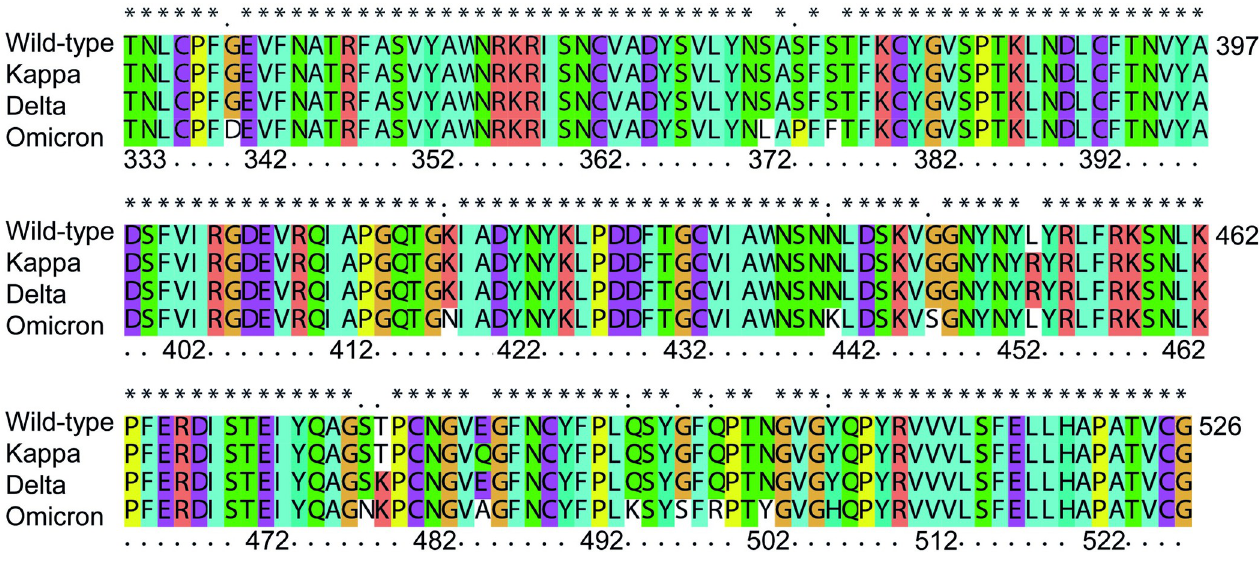
Fig 1. Amino acid sequence alignment in each SARS-CoV-2 S-RBD variant; wild-type, Kappa (B.1.617.1), Delta (B.1.617.2), and Omicron (B.1.1.529). The ACE2 receptor binding domain (RBD, or spike RBD region) are located in residues 438–505.